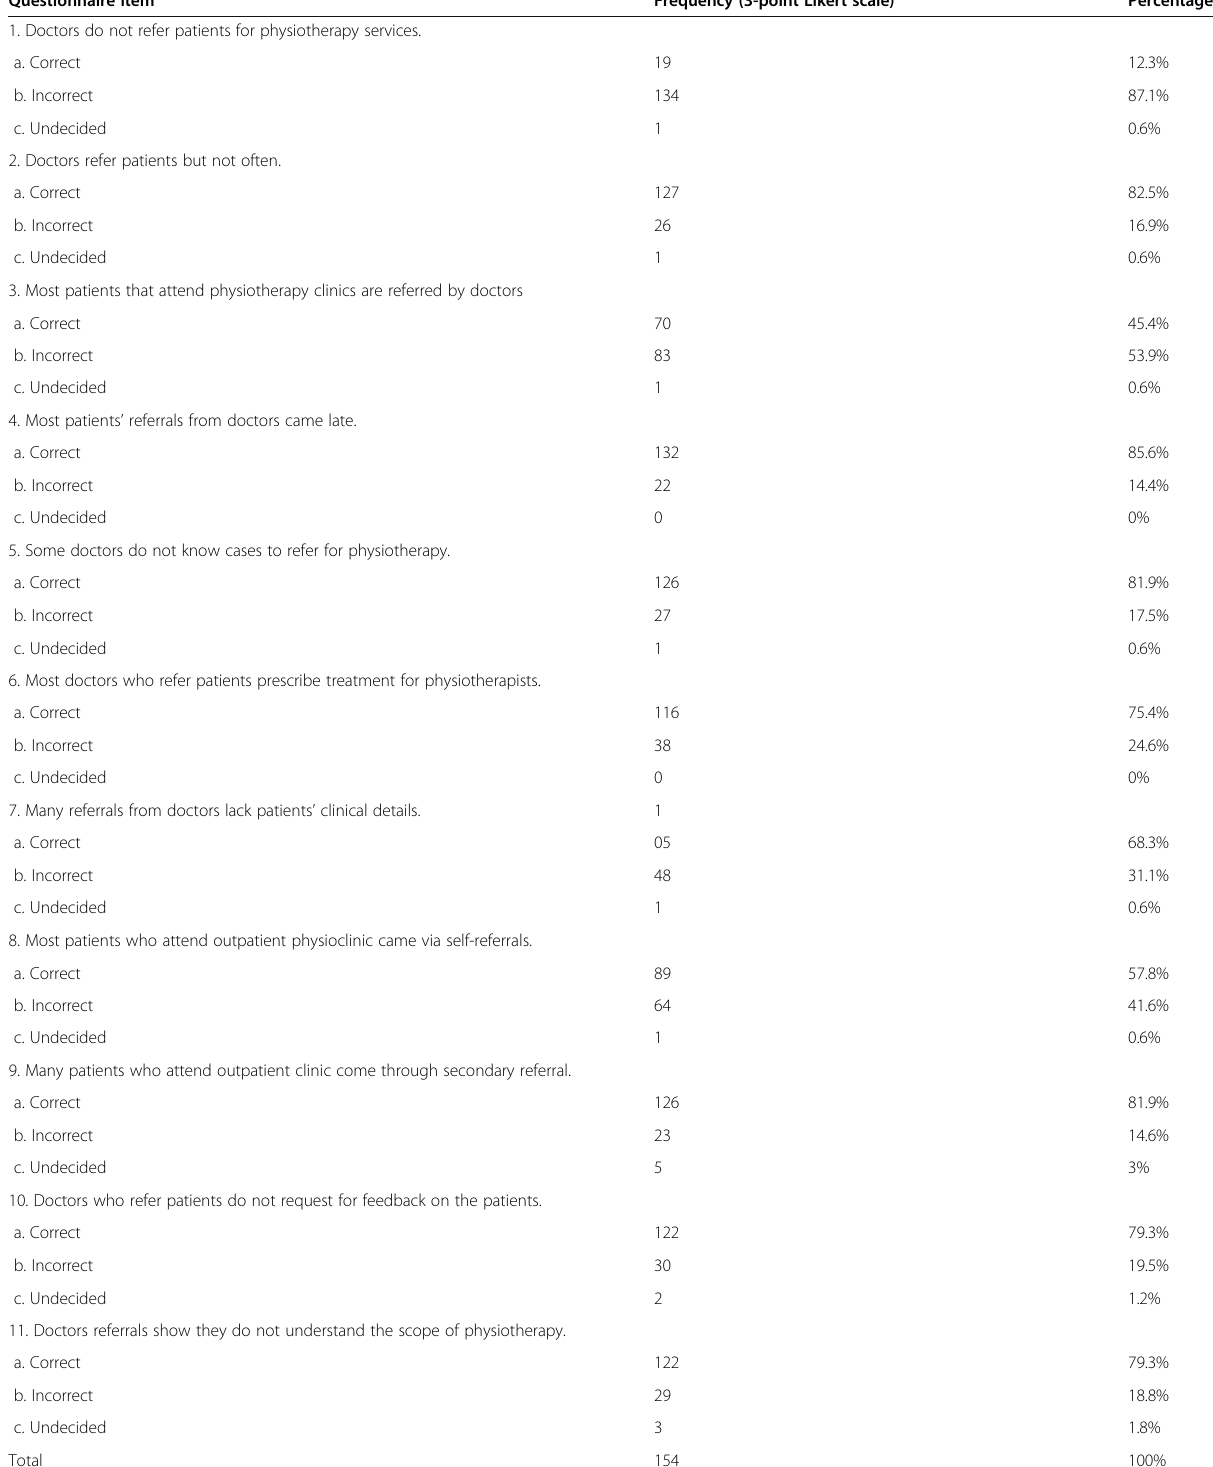
Table 2 Respondents ’ responses to questionnaire items on perception of doctors ’ referral for physiotherapy Questionnaire